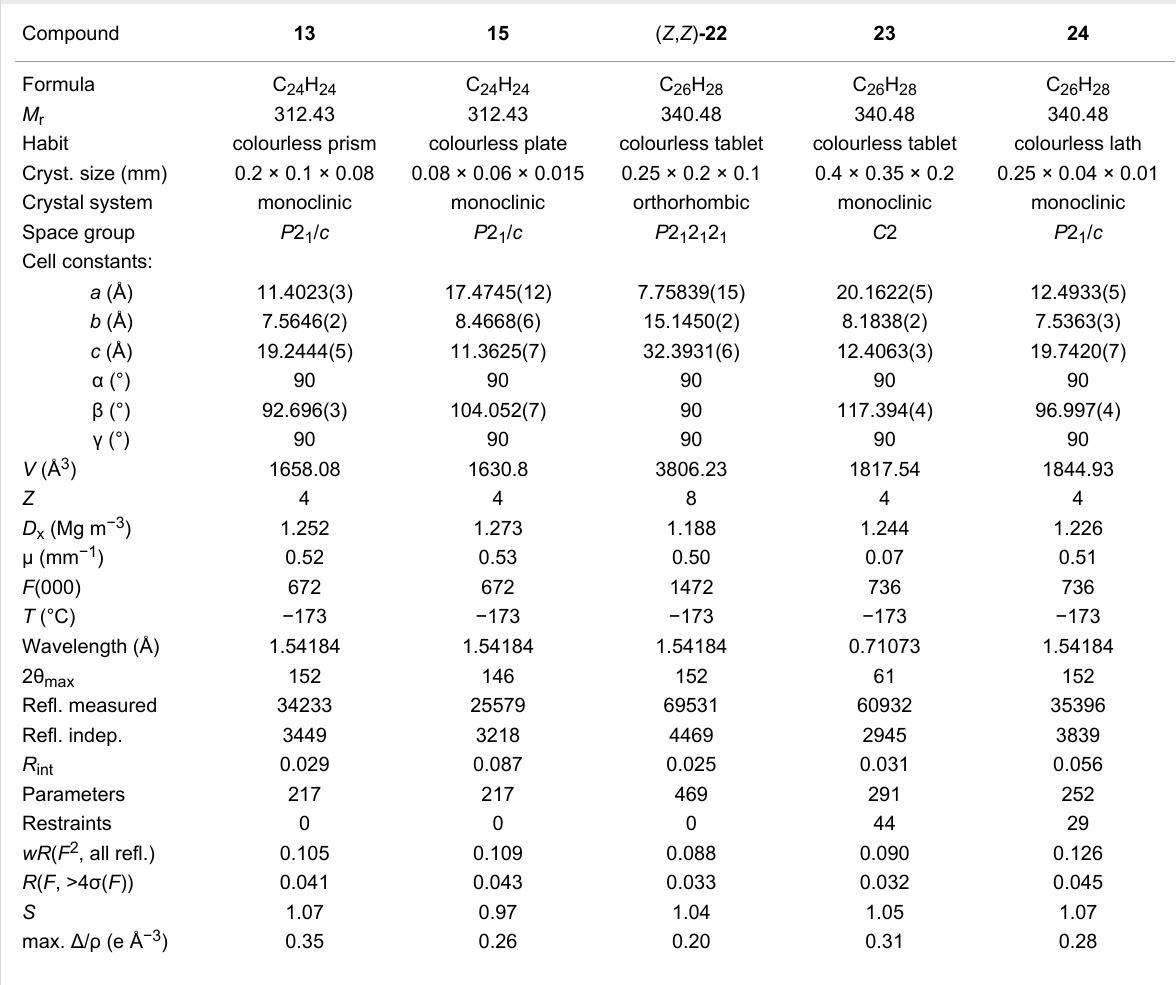
Table 1: Crystallographic data for compounds 13 , 15 , ( Z , Z )- 22 , 23 and 24 .